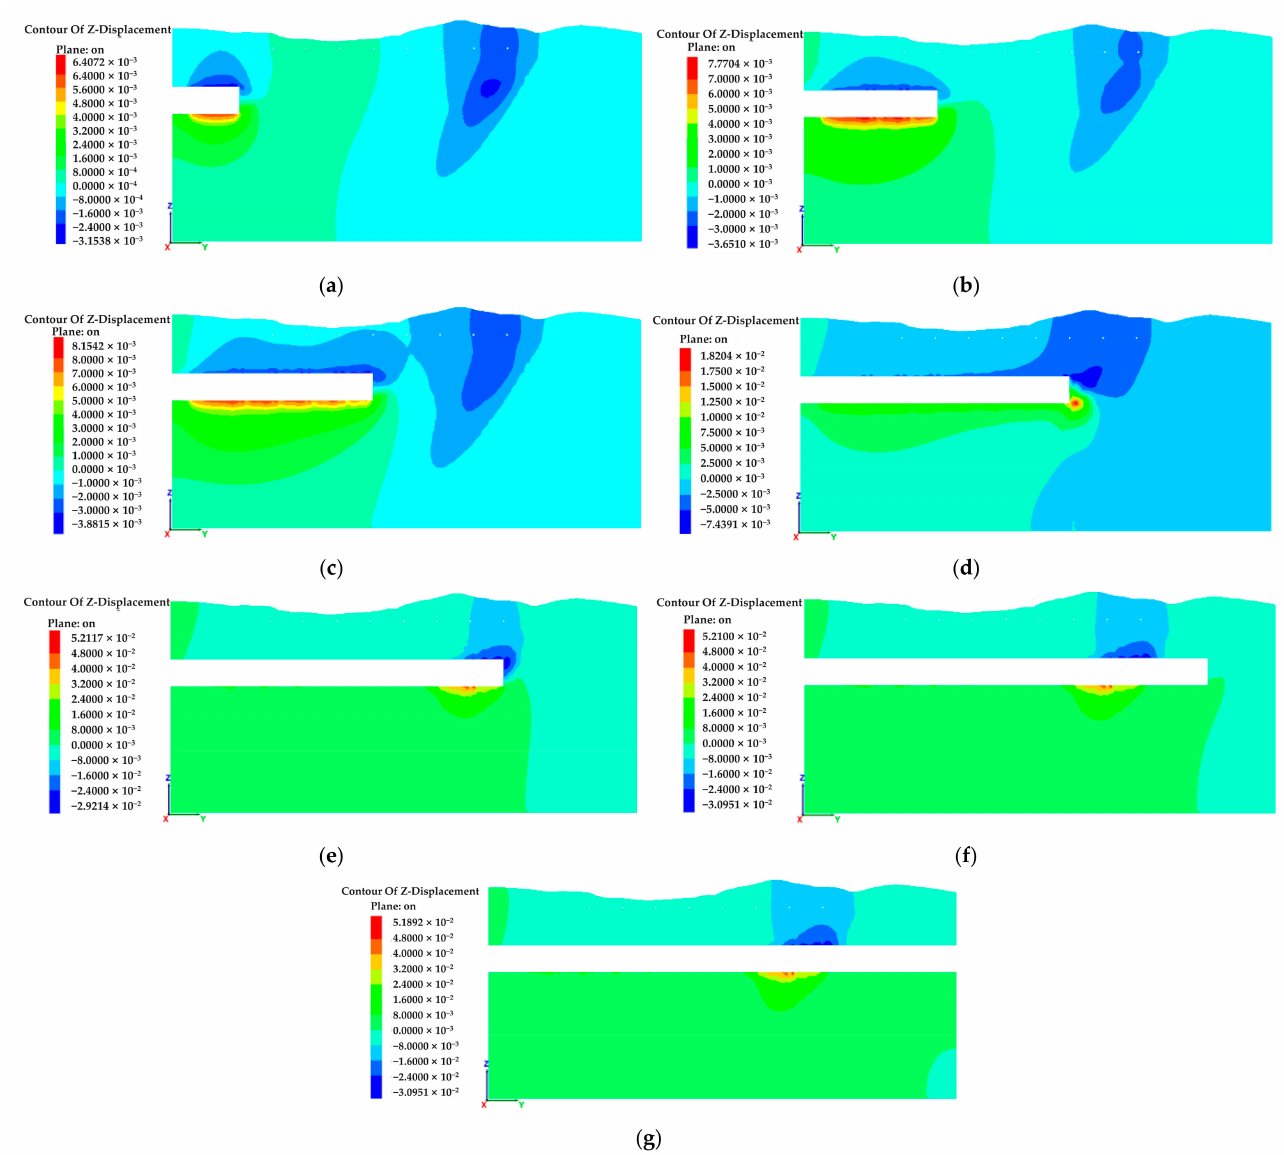
Figure 7. Vertical deformation of surface and surrounding rock during pilot tunnel excavation (unit: m): ( a ) L = 20 m; ( b ) L = 40 m; ( c ) L = 60 m; ( d ) L = 80 m; ( e ) L = 100 m; ( f ) L = 120 m; and ( g ) L = 140